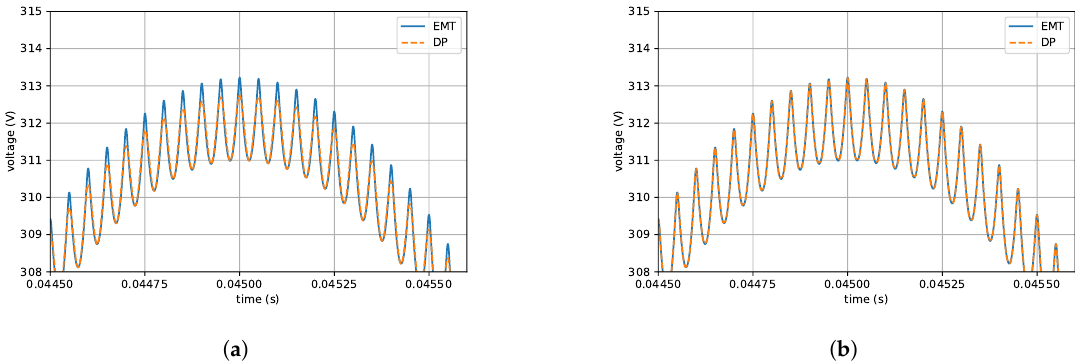
Figure 13. Ripple of the capacitor voltage of a DP inverter model including the fundamental and 8 harmonics ( a ) or 28 harmonics ( b ) as compared to a Simulink EMT model.